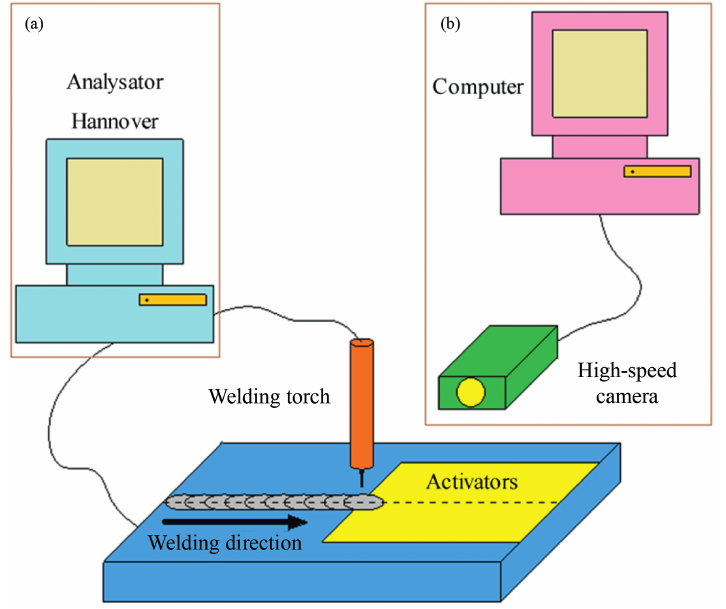
Figure 1: Schematic diagram of activating flux TIG.